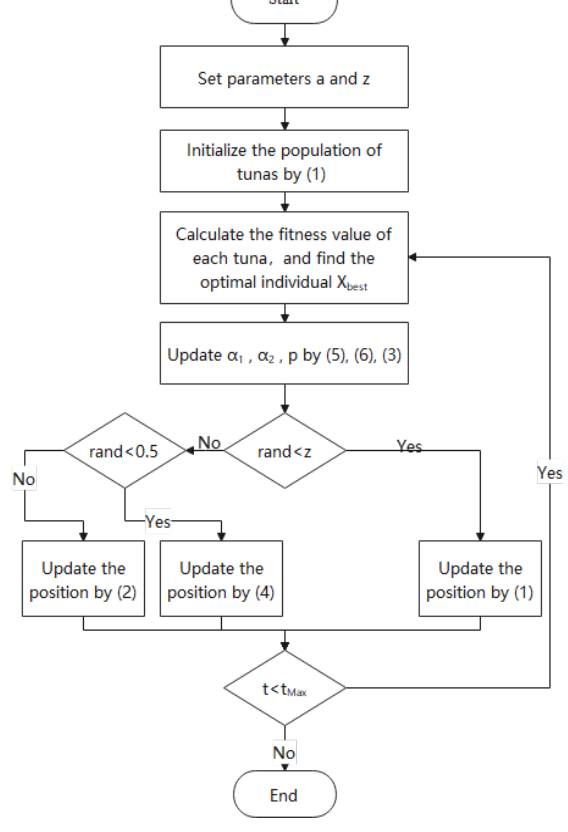
Figure 1. Flow chart of TSO.